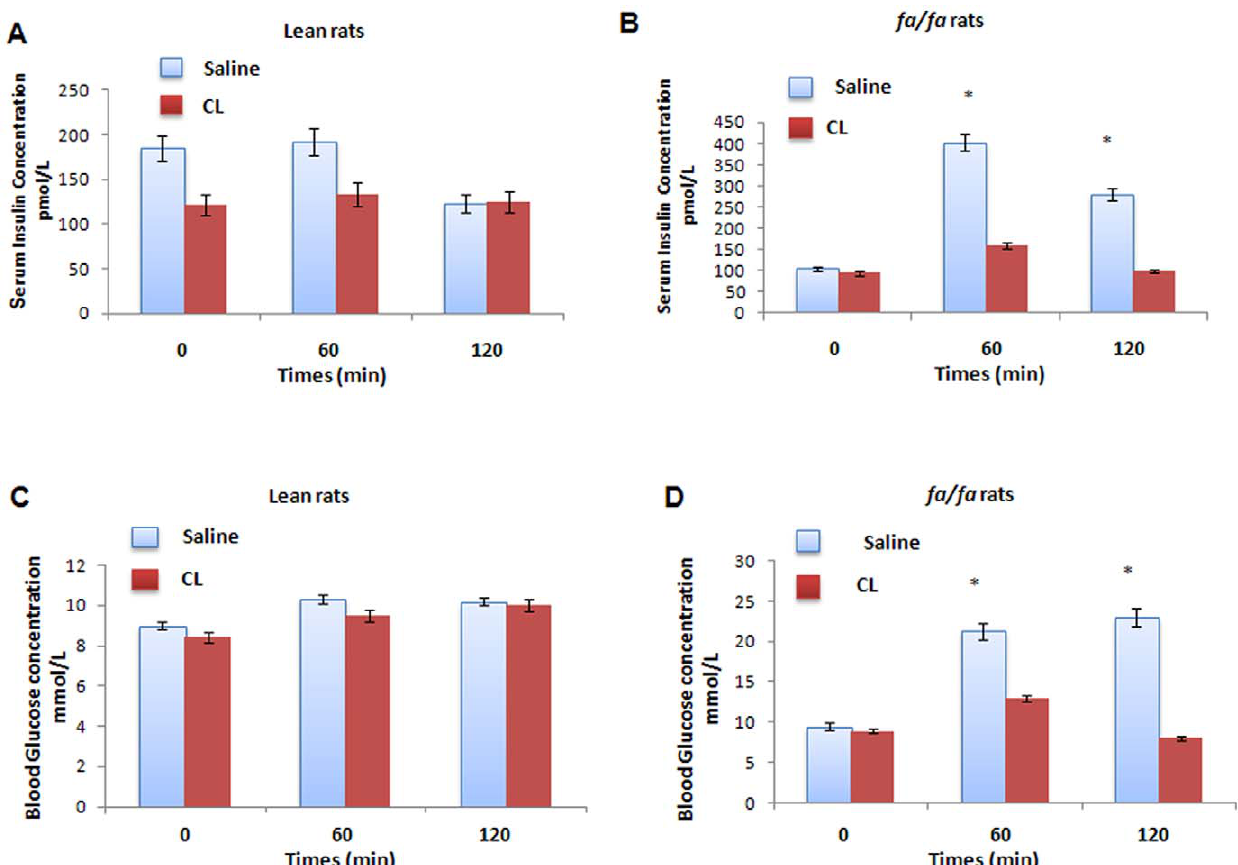
Figure 4. Effect of CL 316,243 on serum insulin (A and B) and blood glucose (C and D) responses during the oral glucose test in the lean and fa/fa rats treated with either saline or CL. * P , 0.05 , compares the significant differences between the two groups of lean and fa/fa rats.